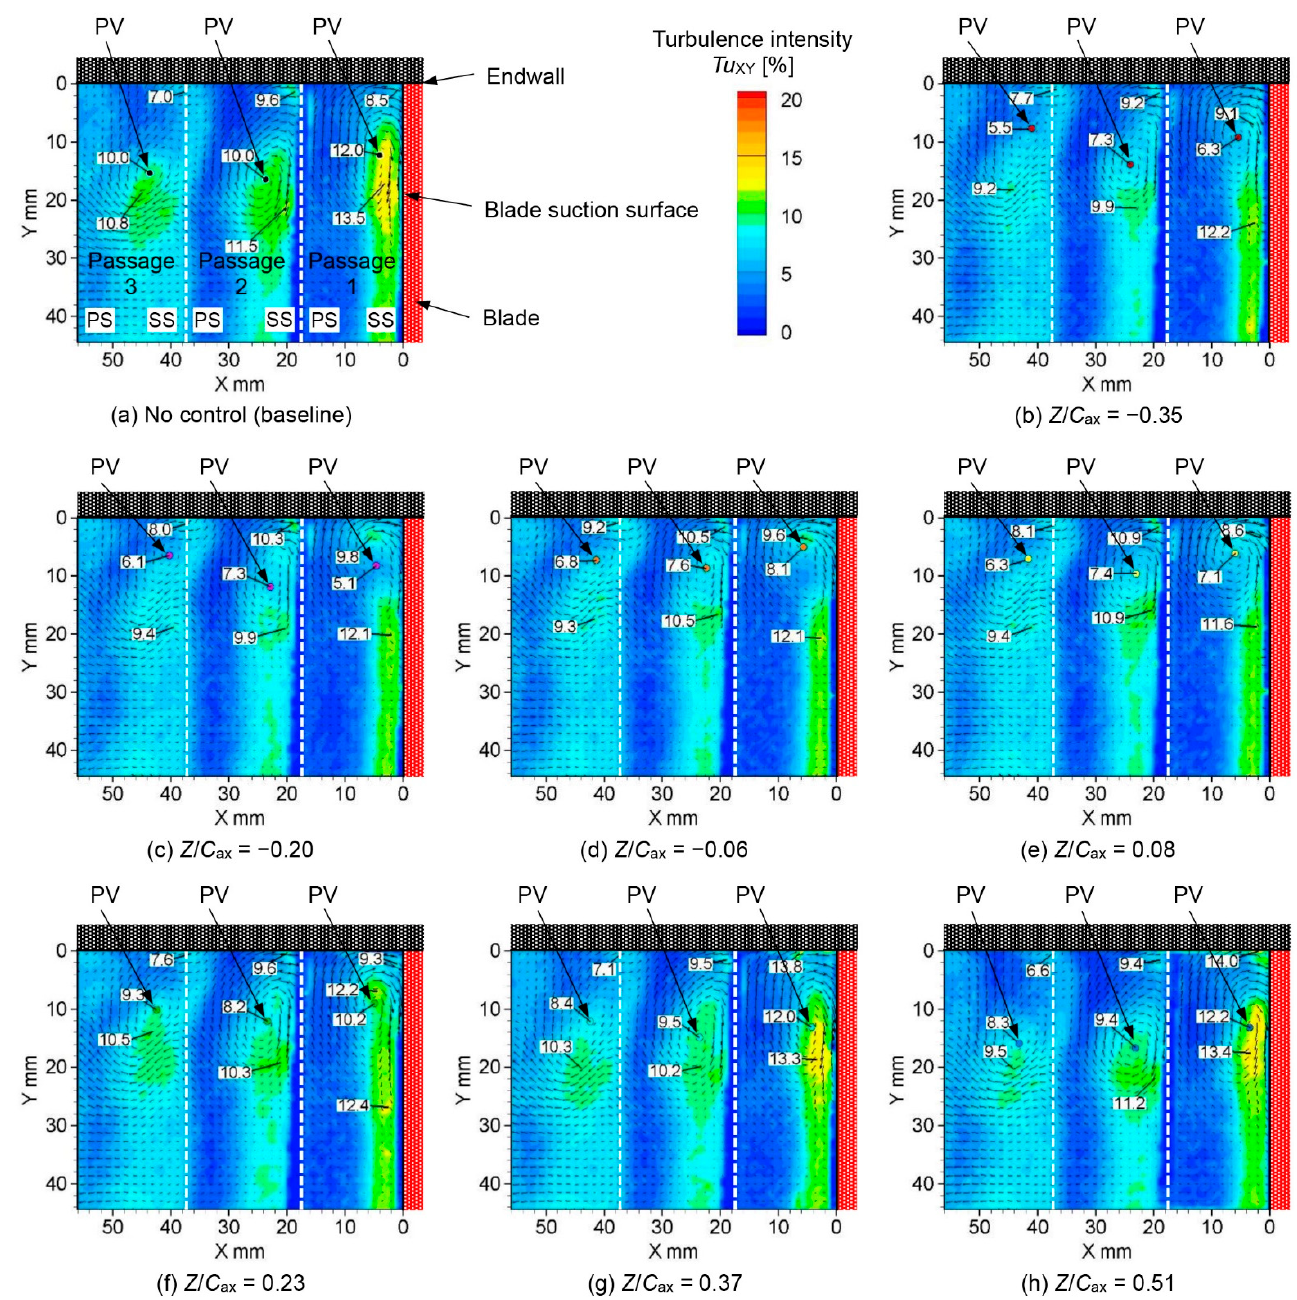
Figure 22. Turbulence intensity distributions of secondary flow at the outlet of the linear turbine cascade at various plasma actuator locations (Re out = 3.7 × 10 4 ).